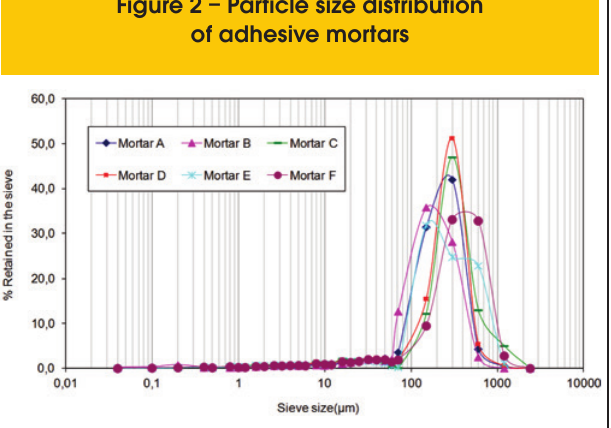
Figure 3 – Particle size distribution for particles